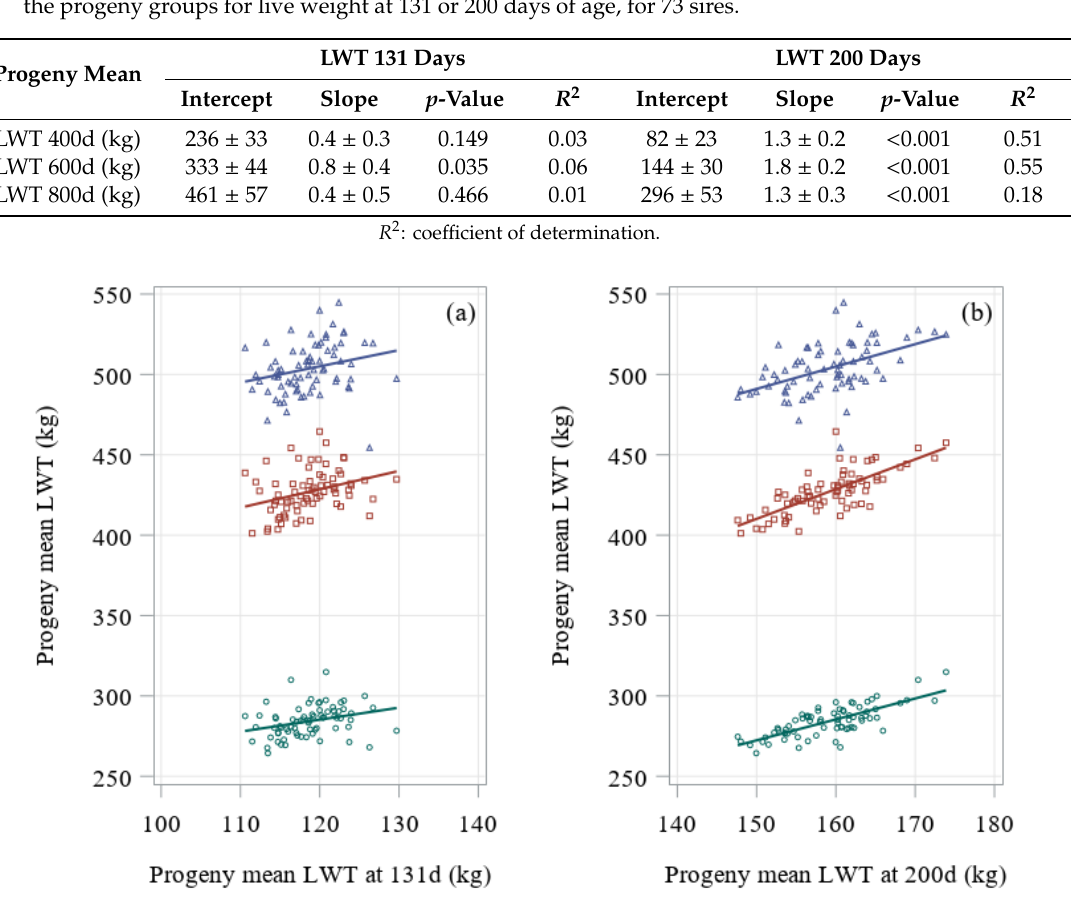
green circles), (cid:35)